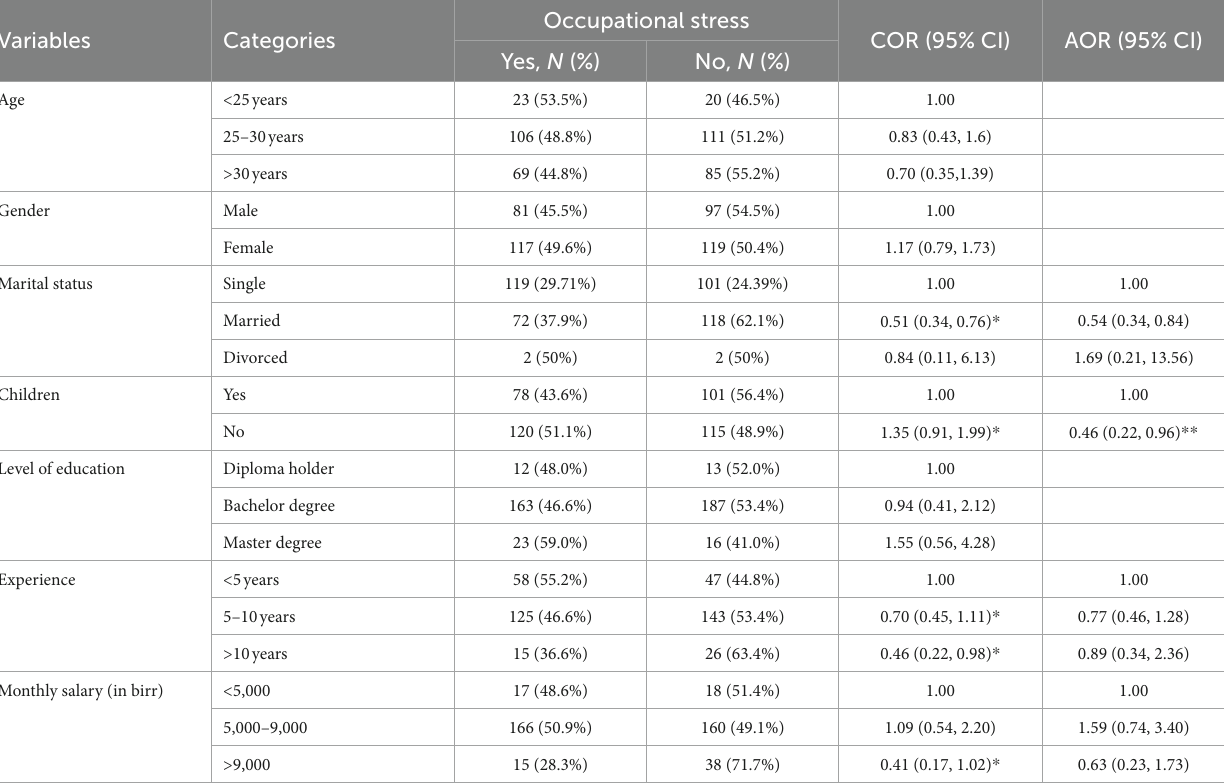
TABLE 4 Socio demographic results of bivariate and multivariate binary logistic regression of factors associated with occupational stress among nurses working at public hospitals of Addis Ababa, Ethiopia, 2022 ( N = 414).